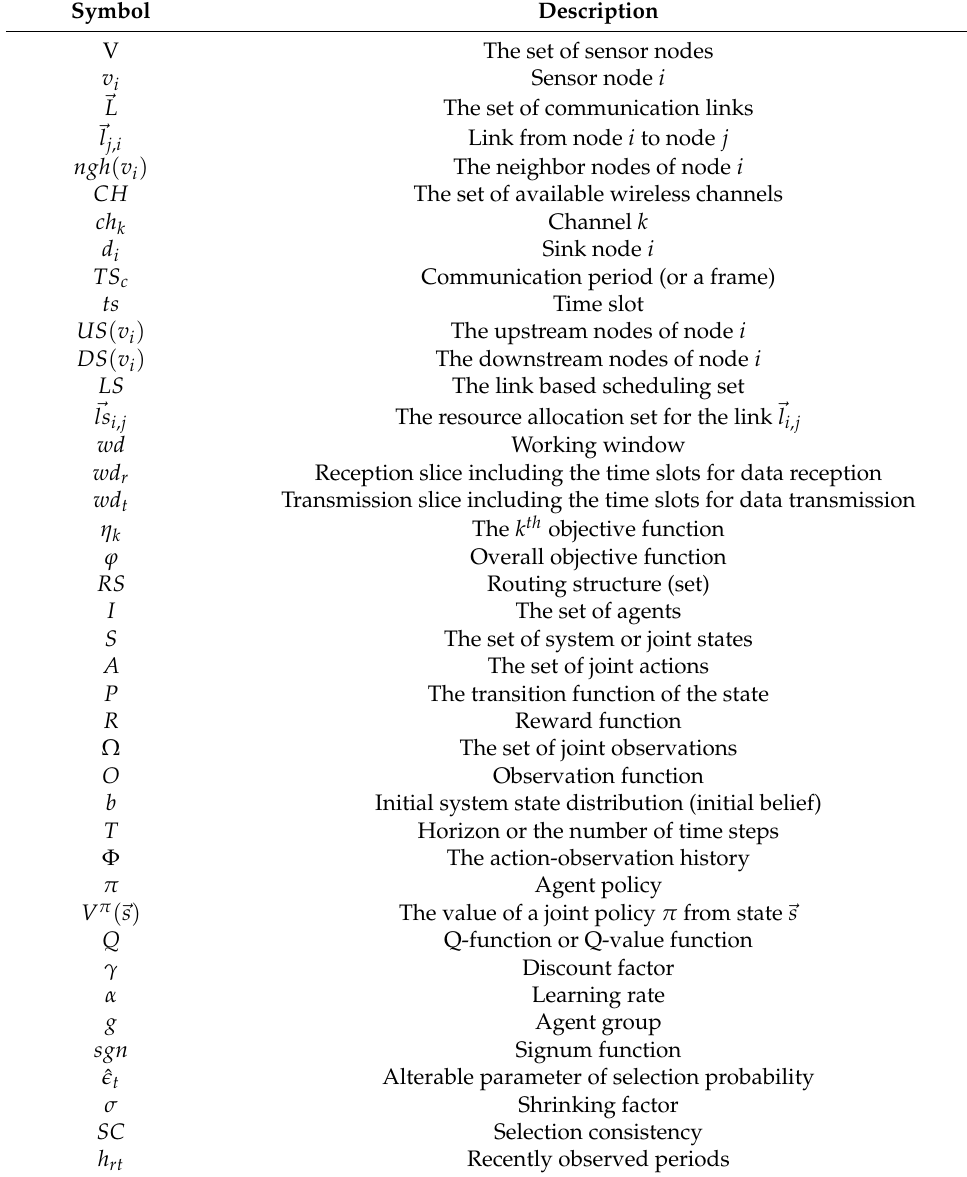
Table A2. Table of